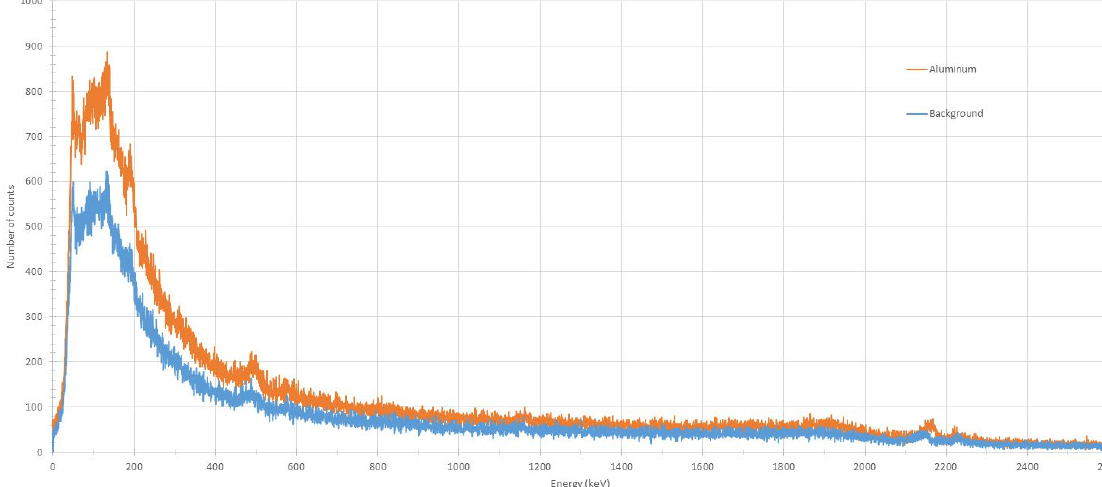
Fig. 13. Prompt gamma-ray spectrum obtained with aluminum at 6